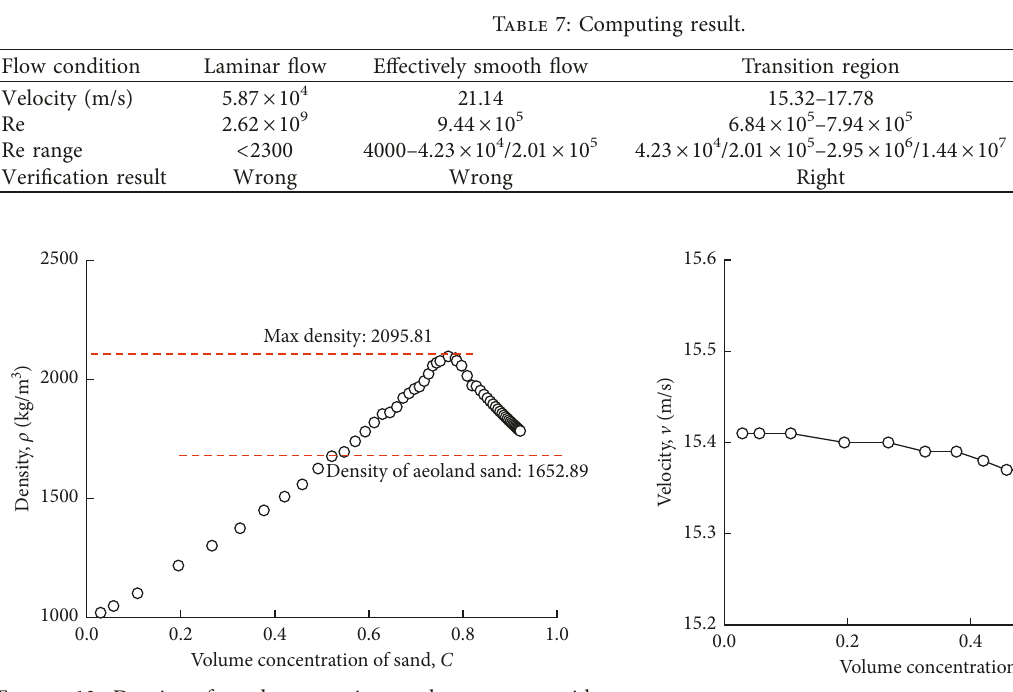
Figure 14: Velocity of sand-water flow change curves with volume concentration of